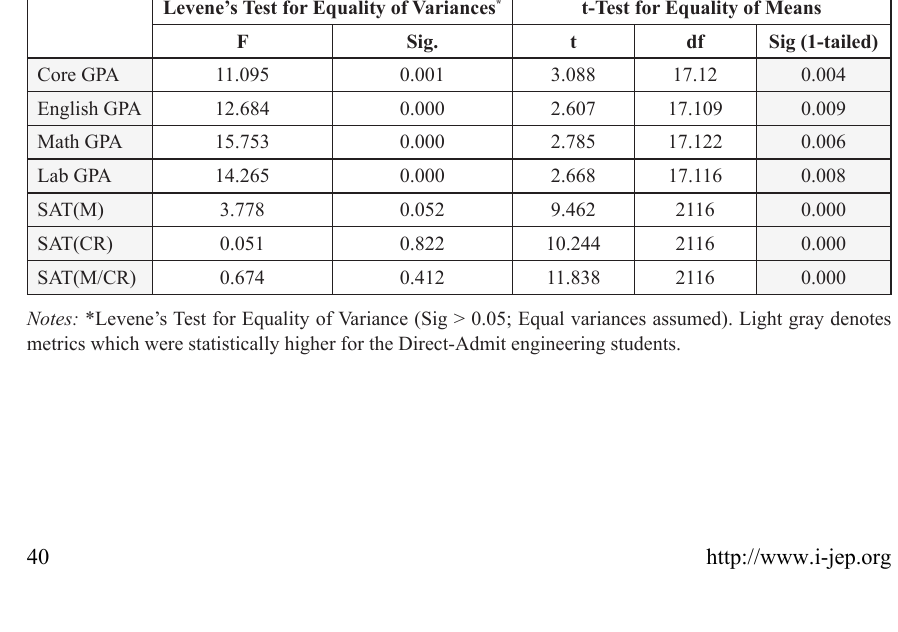
Table 9. Statistical tests for GPA and SAT group equivalence between Purdue Rising Scholars and Engineering students from SPSS ® Levene’s Test for Equality of Variances * t-Test for Equality of